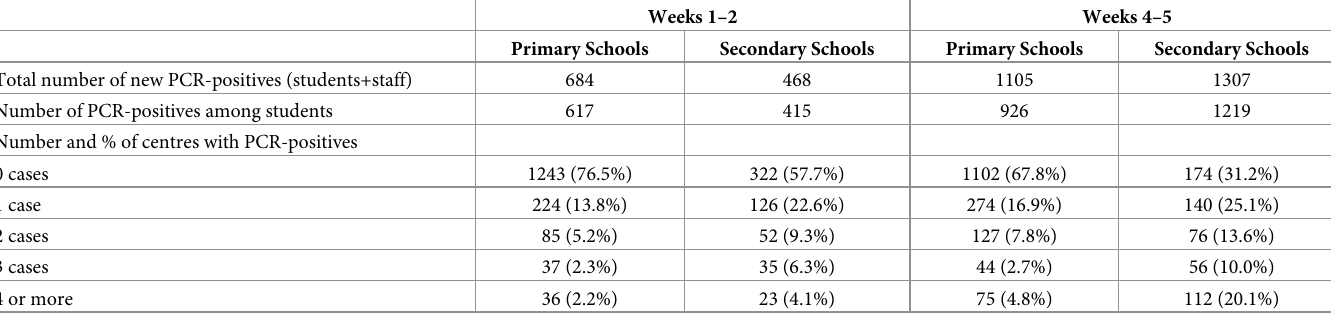
Table 1. Characteristics of the study population by type of centre and